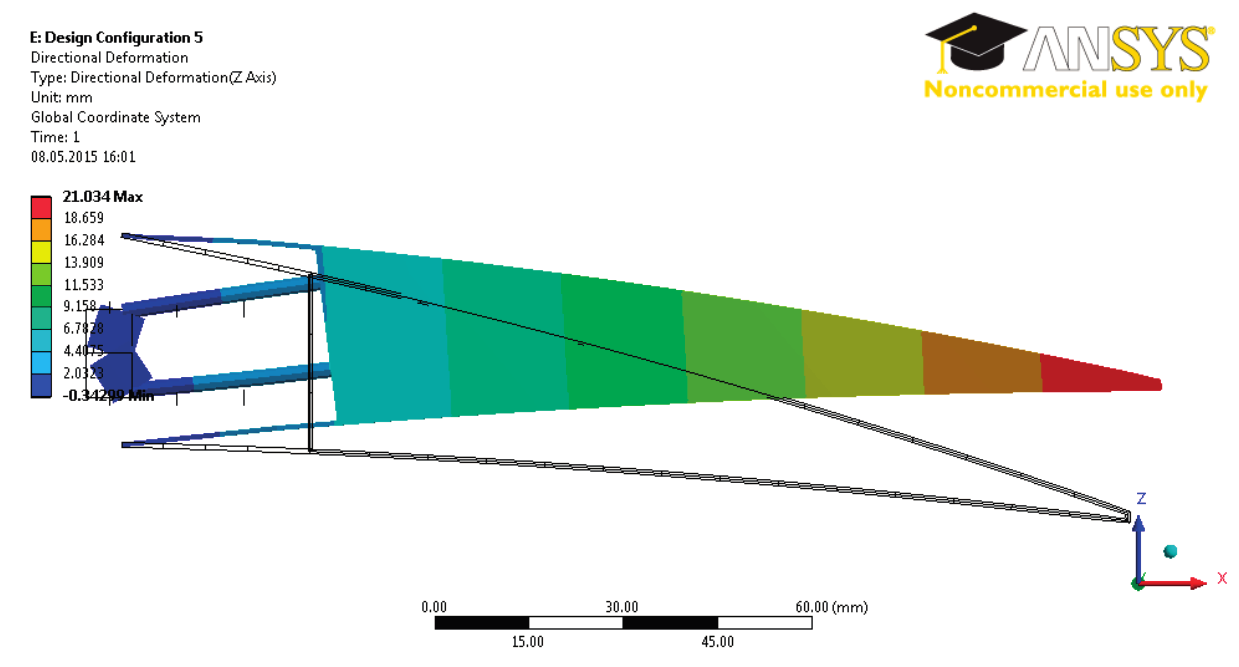
Figure 24. Deformation along Z -axis for design configuration